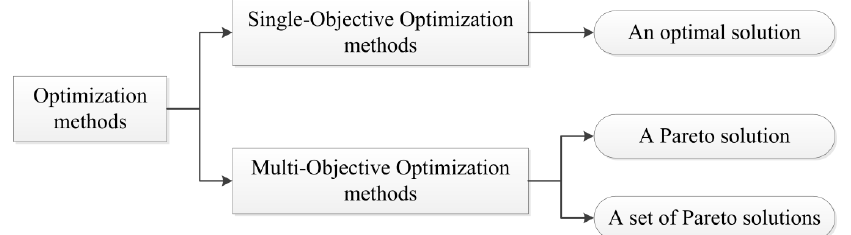
Figure 3. Types of optimization methods and their targeted solutions.